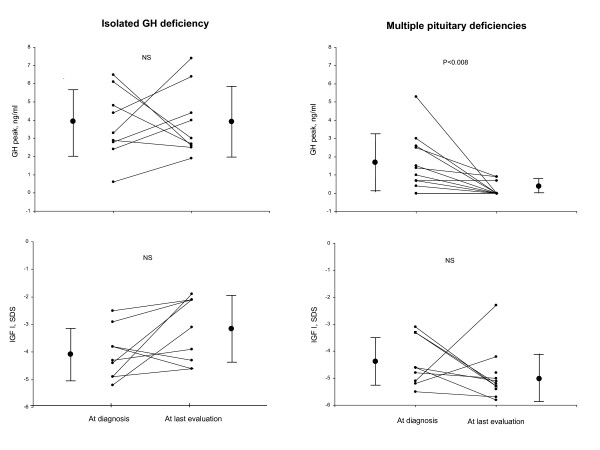
Data for each of 21 patients with GH deficiency with pituitary stalk interruption syndrome at diagnosis and after GH treatment classified according to whether there was isolated GHD (n = 9) or multiple.